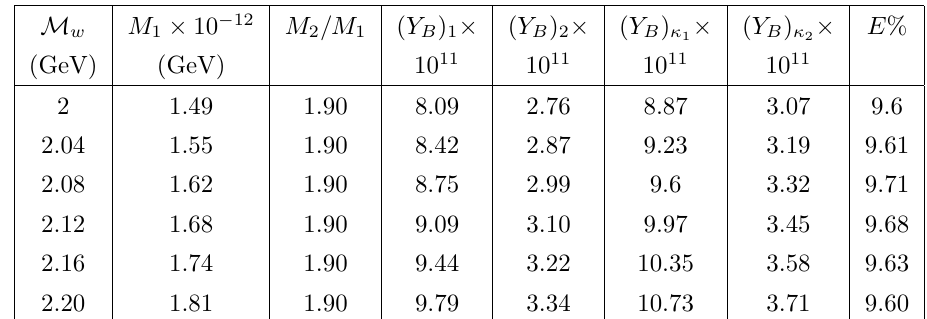
Table 4 . Comparison between the (cid:12)nal baryon asymmetry evaluated by direct numerical solution of Boltzmann equations with those calculated using the analytical formulas (i.e. using (cid:20) f and ( Y B ) 2 denote the results produced by the solution of Boltzmann equations with and without pure N 2 contribution respectively. Similarly ( Y B ) (cid:20) asymmetry evaluated using the analytical formula. E is the percentage errors given by E % = (cid:12)